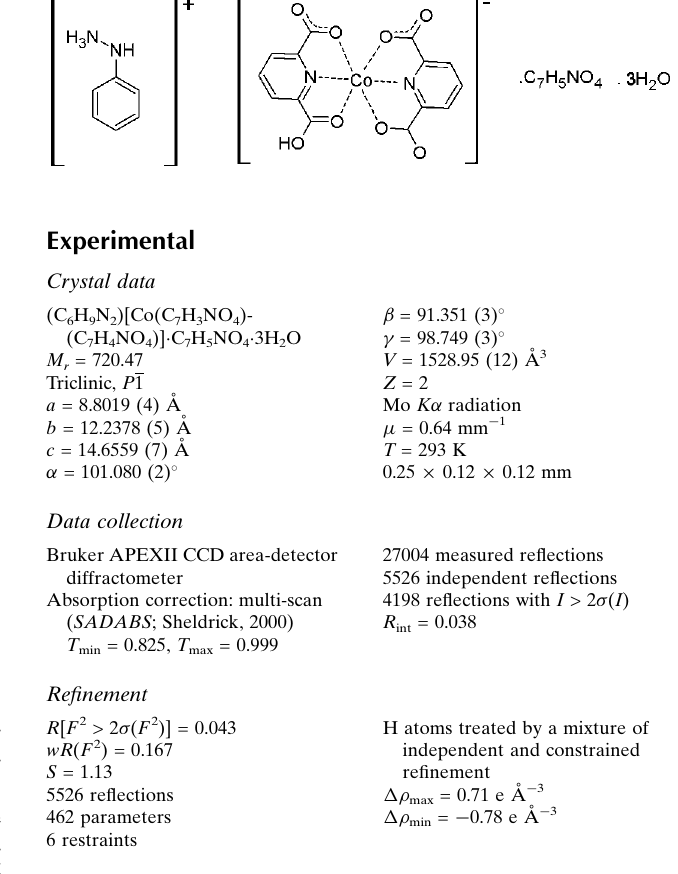
Data collection